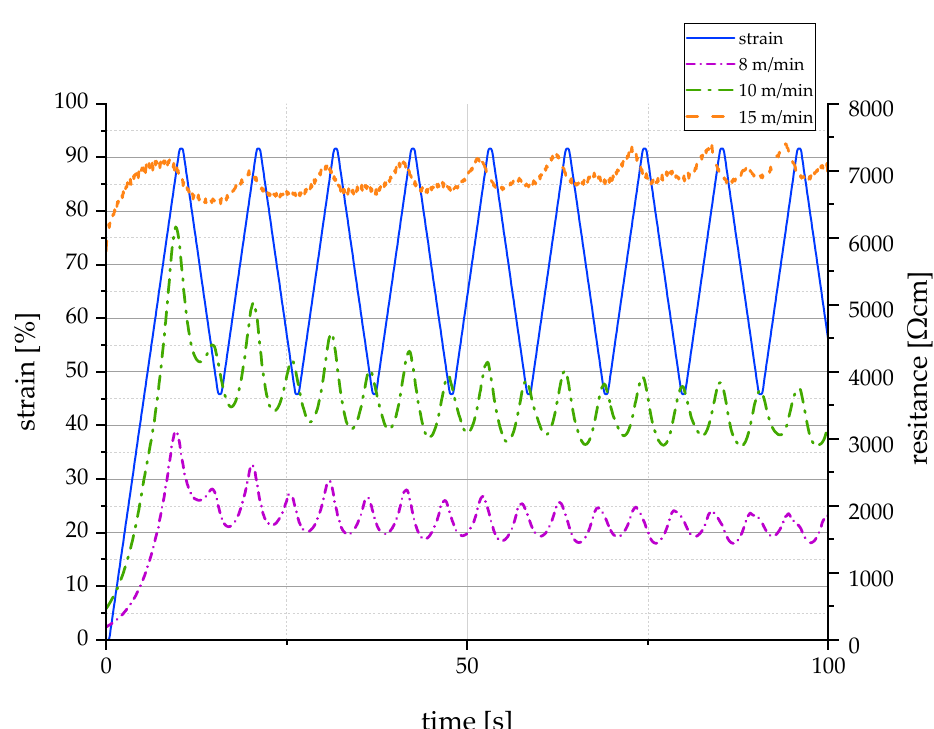
Figure 7. Correlation between mechanical elongation and electrical resistance for filament yarns containing 5 wt.% CNT and melt spun at different winding speeds.